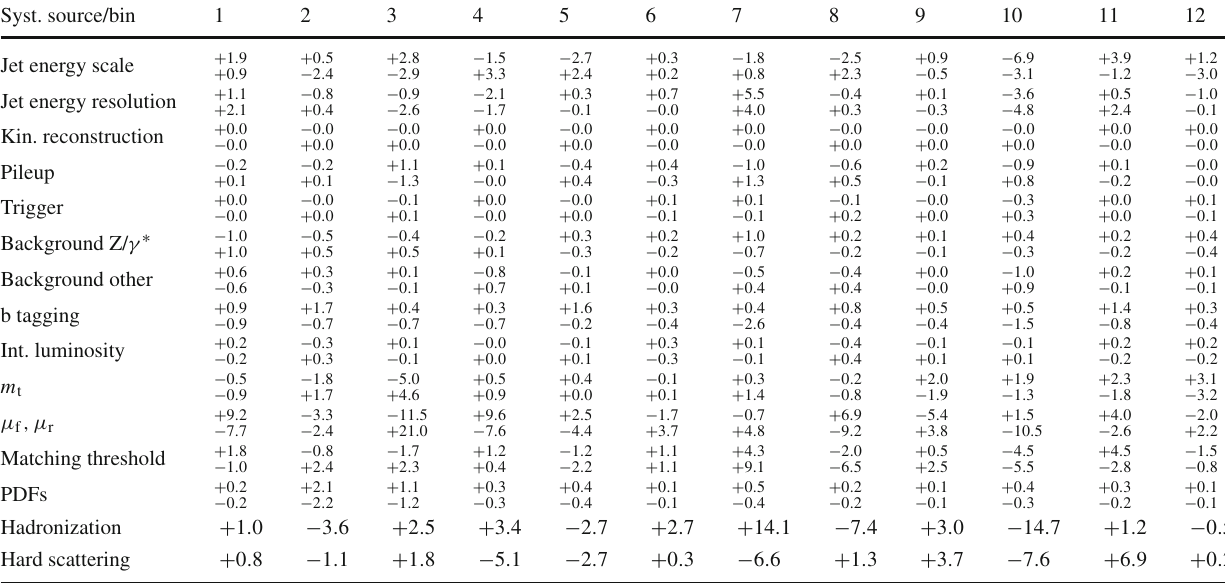
Table 22 Sources and values of the relative systematic uncertainties in percent of the measured normalized tt double-differential cross sections as a function of M ( tt ) and Δφ( t , t ) . For bin indices see Table 20 Syst. source/bin Jet energy